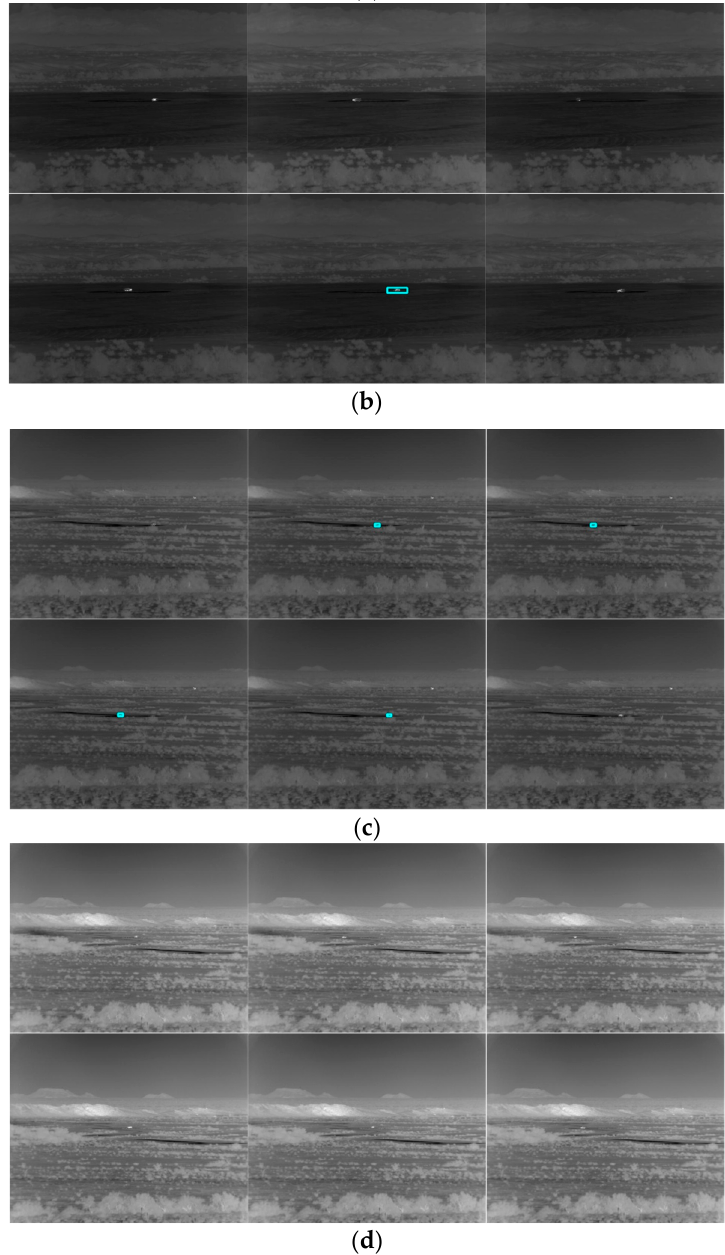
Figure 11. Tracking results for frames 1, 60, 119, 178, 237, and 296 for the PCE full (MWIR nighttime) case. The vehicle is SUV. ( a ) 1000 m; ( b ) 2000 m; ( c ) 2500 m; and ( d ) 3500 m.